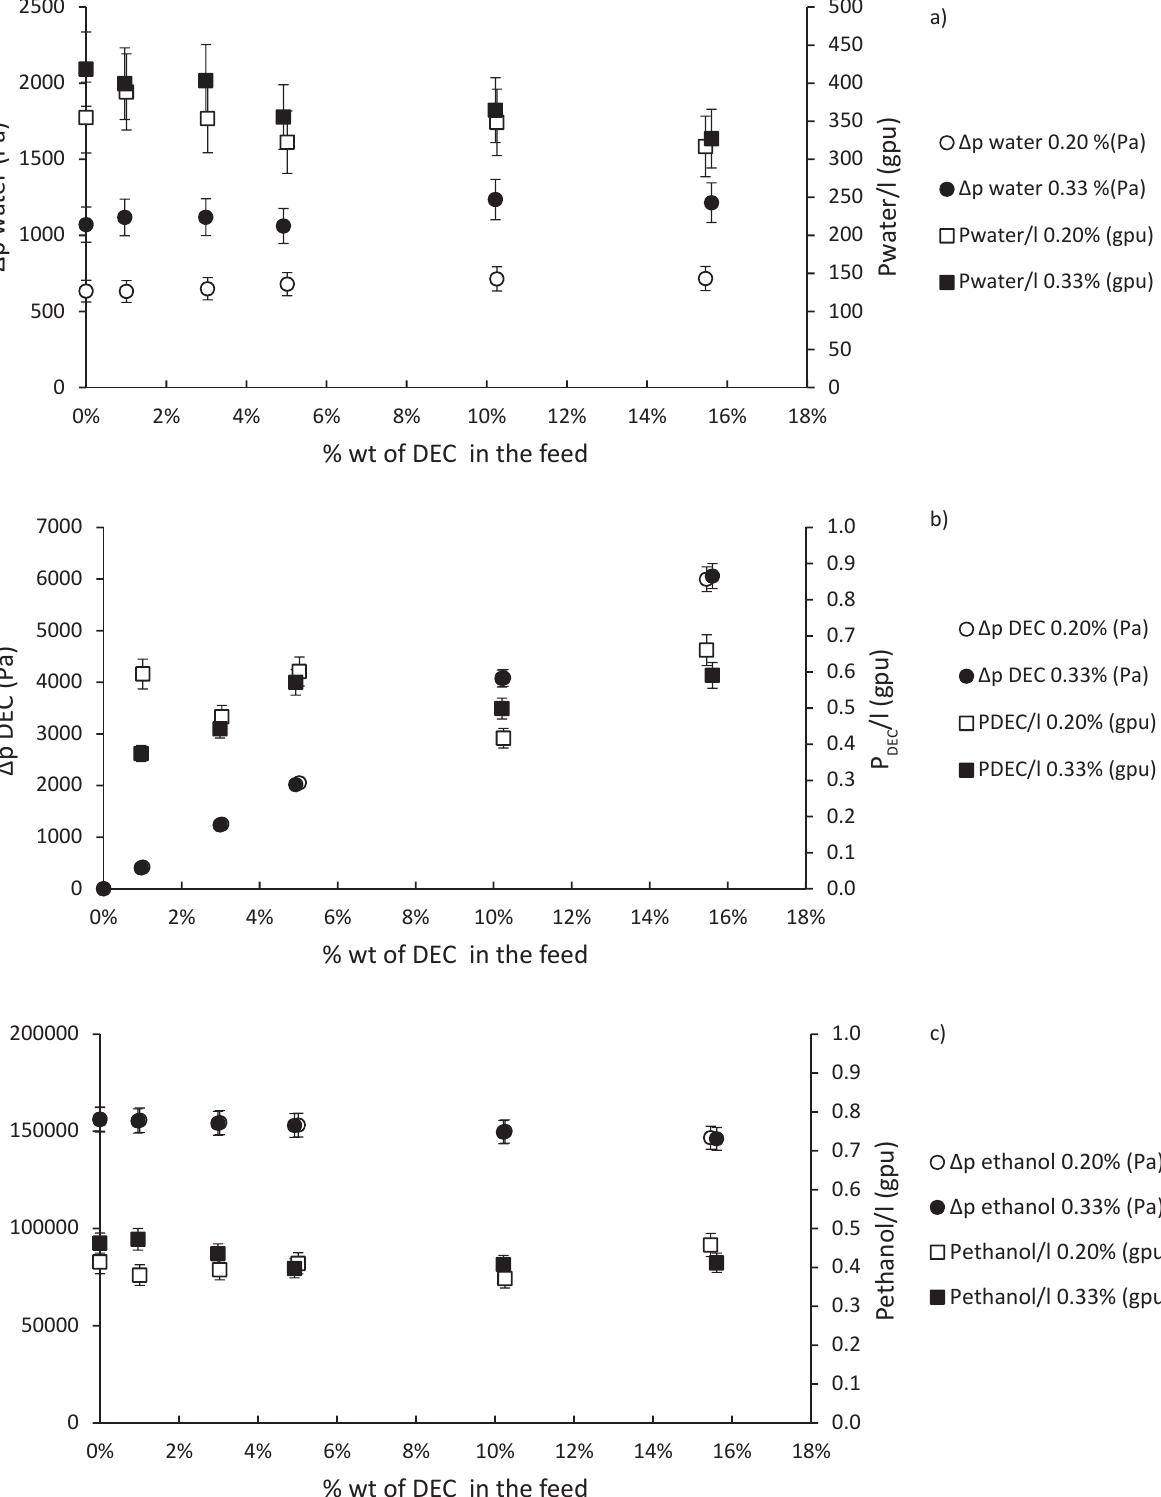
Figure 11: Influence of the amount of DEC on the pressure gradient and permeance of (a) water, (b) DEC and (c)